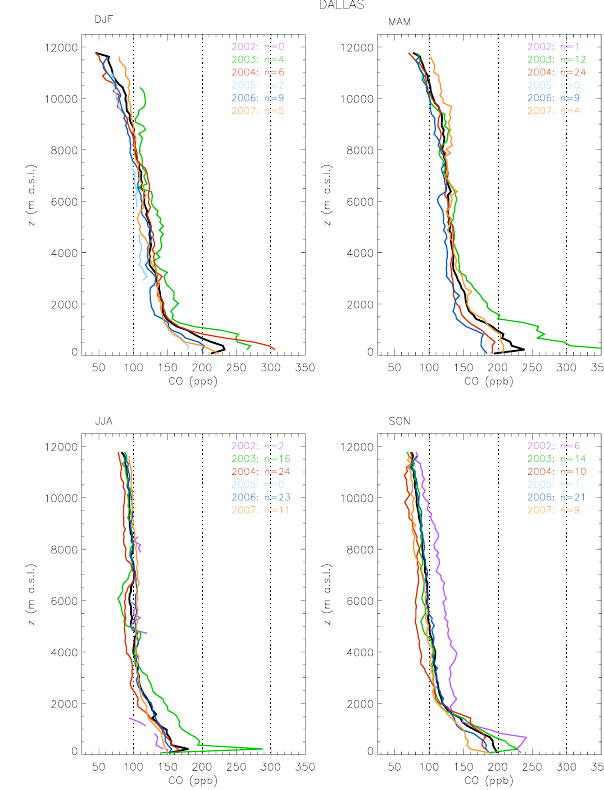
Fig. 3. Same as Fig. 1 but for Caracas. Fig. 4. Same as Fig. 1 but for